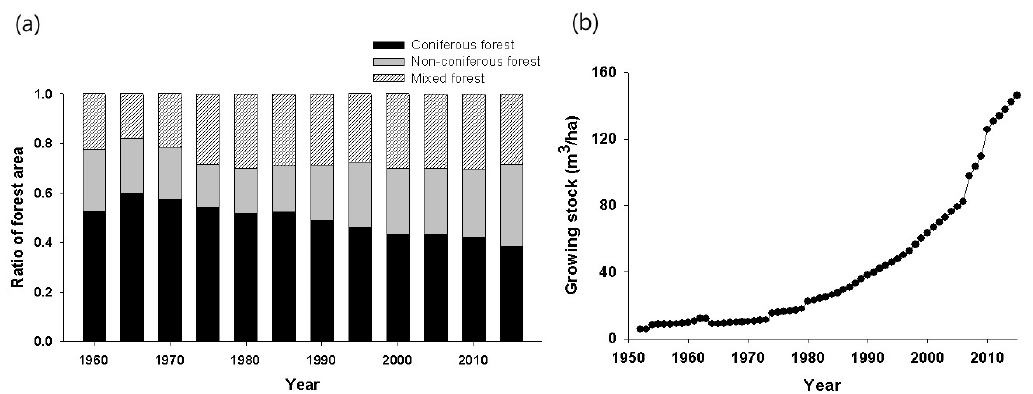
Figure 1. ( a ) Changes of forest composition in Korea from 1960 to 2015 and ( b ) annual changes in forest growing stock (m 3 /ha). The graphs were redrawn based on data from Statistical Yearbook of Forestry [14] .